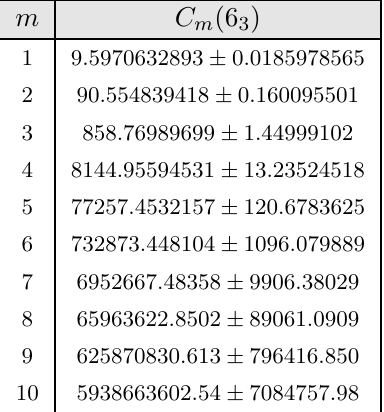
Table 14. Values of C m (6 3 ) . Figure 22. Variation of ln C m (6 3 ) with m